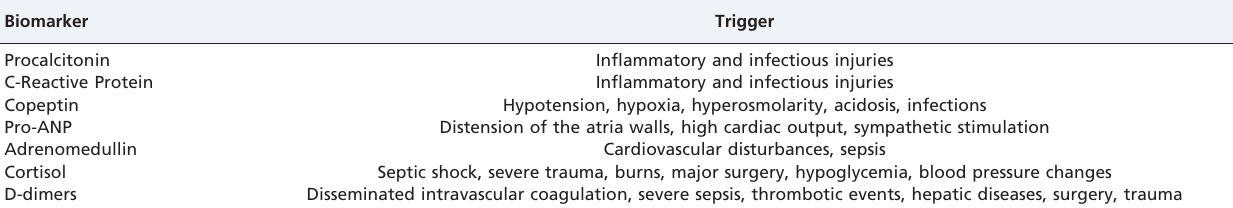
Table 1 - Summary of the studied biomarkers and